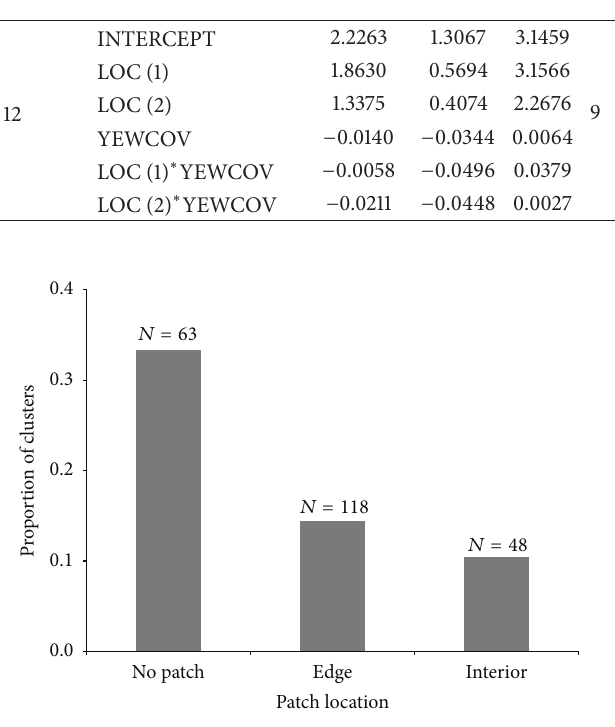
Figure 4: Proportion of sampled Canada yew clusters containing ≥ 1 dead stems in relation to distance from yew patch edge from 24 stands in Marquette and Alger counties, MI, 2001-2002. Only those clusters with 5 Canada yew stems were included in analysis. Numbers above each category represent total number of clusters